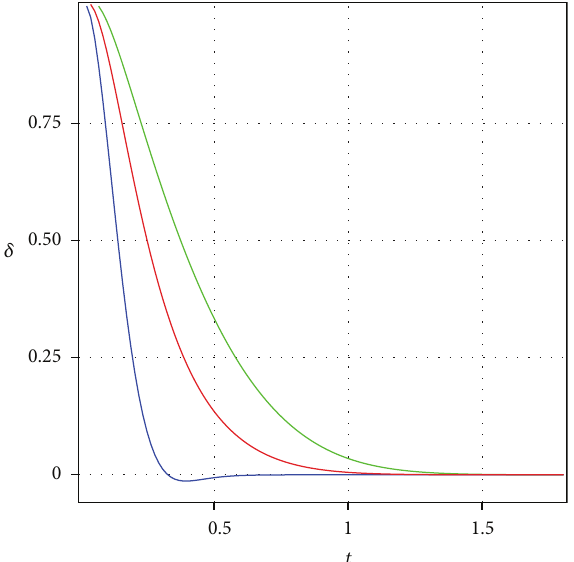
Figure 13: Squared sound speed for 𝐵 = 3 , 𝐶 1 = 0.01 , 𝑛 = 1 , and 𝐴 = 1/3 . 𝛼 = 1 (green line), 𝛼 = 0.7 (blue line), 𝛼 = 0.5 (black line), 𝛼 = 0.1 (red line).